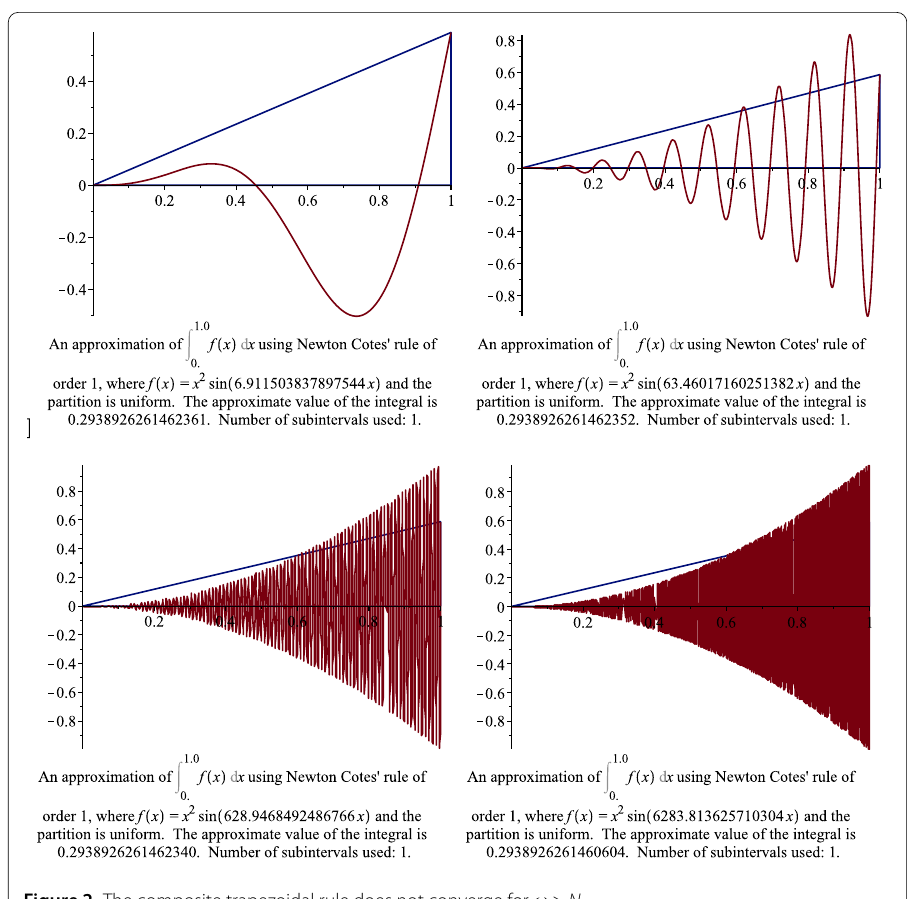
Figure 2 The composite trapezoidal rule does not converge for ω >